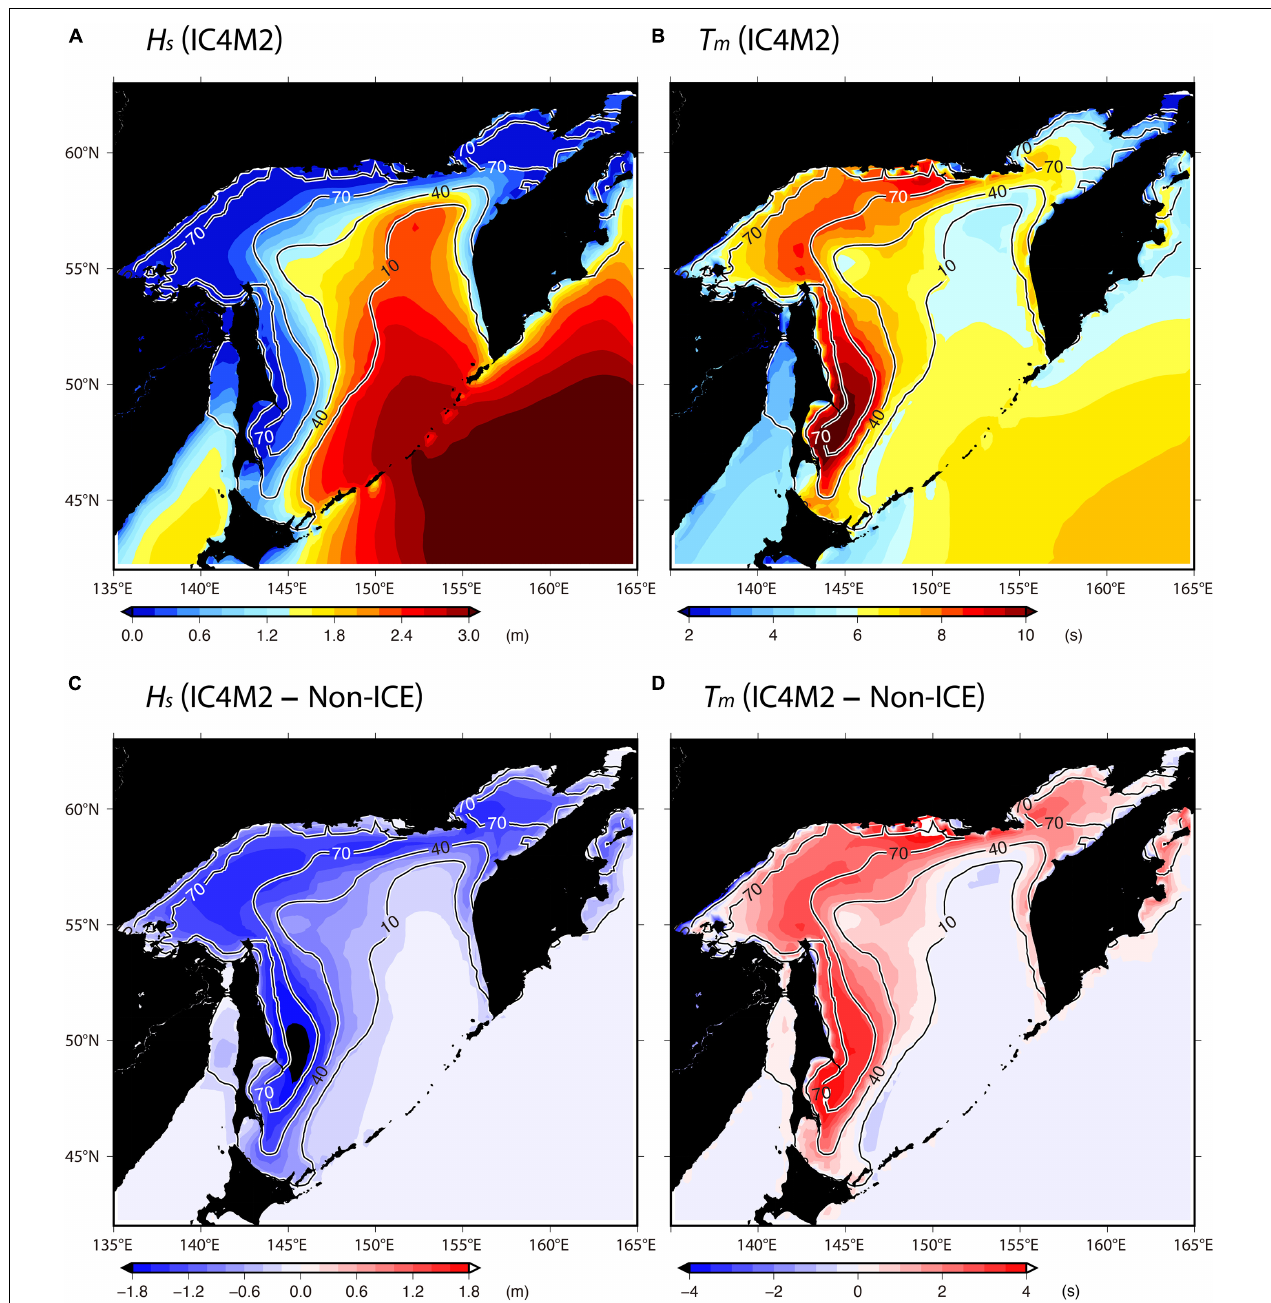
FIGURE 8 | Averaged field (color) of (A) H s and (B) T m computed by IC4M2 in February during 2008–2010; difference (color) between IC4M2 and Non-ICE simulations; (C) H s ; (D) T m . Both simulations are modeled results with ST6. Spatial smoothing using a box filter of horizontal scale 50 km was performed for the ice concentration (contour) (%). In this figure, we used the model results from domain